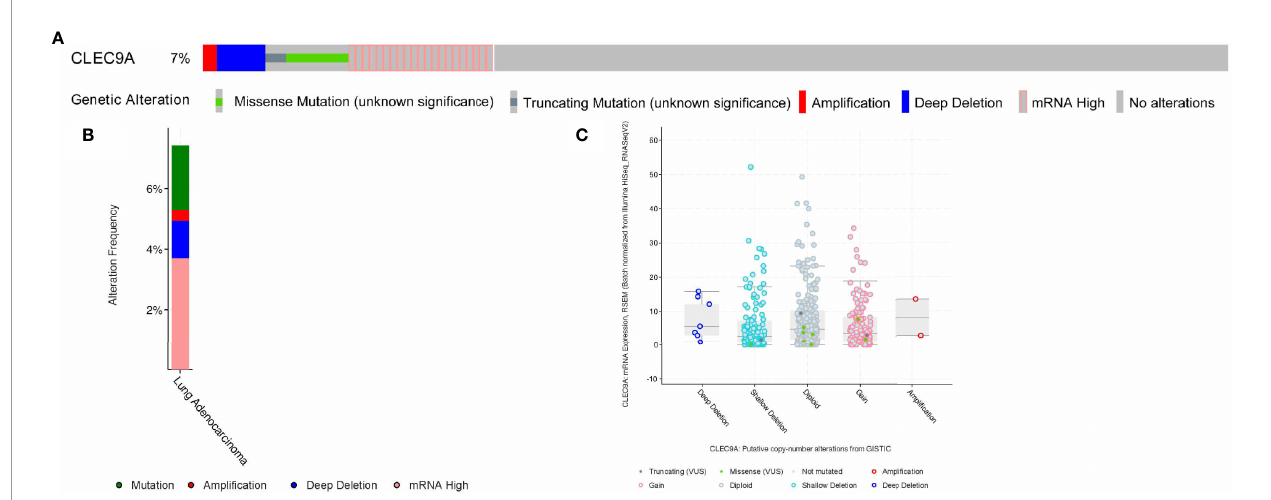
FIGURE 2 | Visual summary of CLEC9A alterations in LUAD. The different types of genetic alterations are highlighted in different colors. (A) CLEC9A alterations in LUAD. (B) The alteration frequency of CLEC9A in LUAD. (C) Expression of CLEC9A in different altered states.